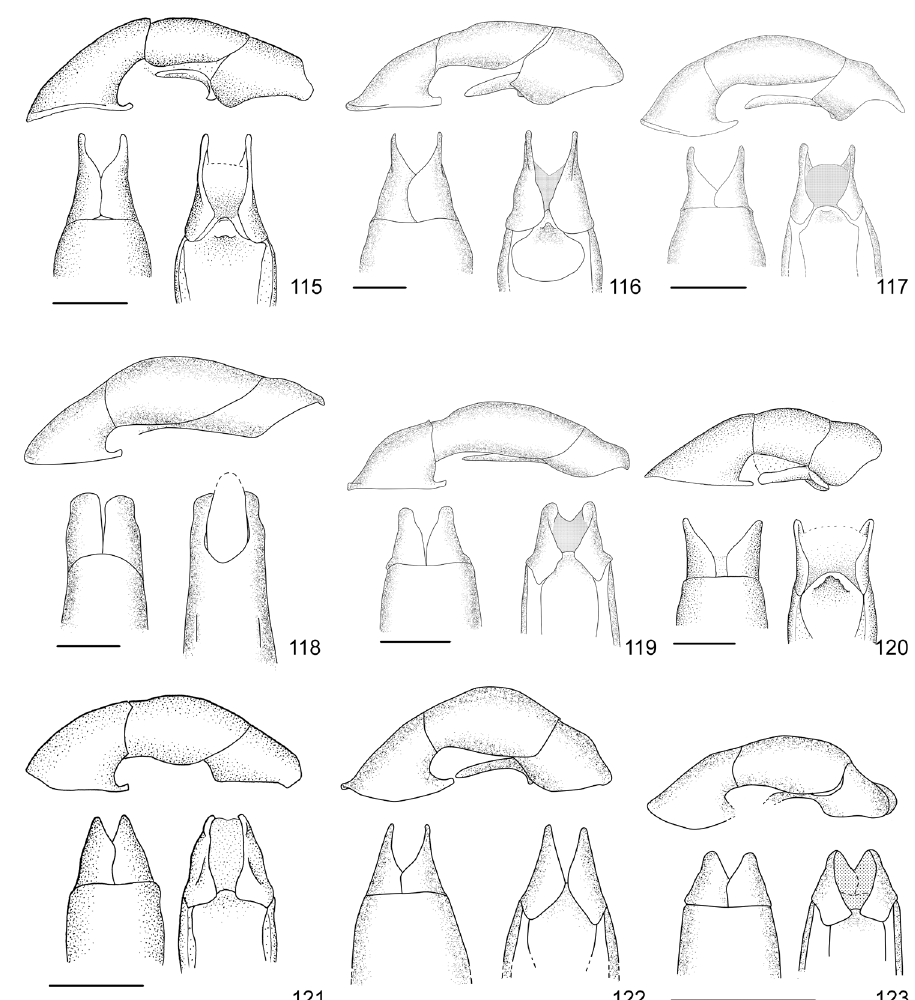
Figures 115–123. Shape of aedeagus, lateral view (top), dorsal view (bottom left), ventral view (bottom right). 115 Anomala aereiventris (Parque Nacional Tapantí, Cartago, MNCR) 116 A. aglaos (Isla Bonita, Alajuela, CEUA) 117 A. antica (Estación Palo Verde, Guanacaste, MNCR) 118 A. arara (Estación Ca- bro Muco, Guanacaste, CEUA) 119 A. arthuri (Estación Maritza, Guanacaste, MNCR) 120 A. aspersa (Villa Mills, Cartago, MNCR) 121 A. atrivillosa (Estación Barva, Heredia, MNCR) 122 A. balzapambae (Rancho Quemado, Puntarenas, MNCR) 123 A. calligrapha (Cabro Muco, Guanacaste, CEUA). Scale bars: 1 mm. Figs 118–119 modified from Filippini et al. (2014); Figs 116–117 modified from Filippini et al. (2015b); Figs 115, 120–121 from Filippini et al.